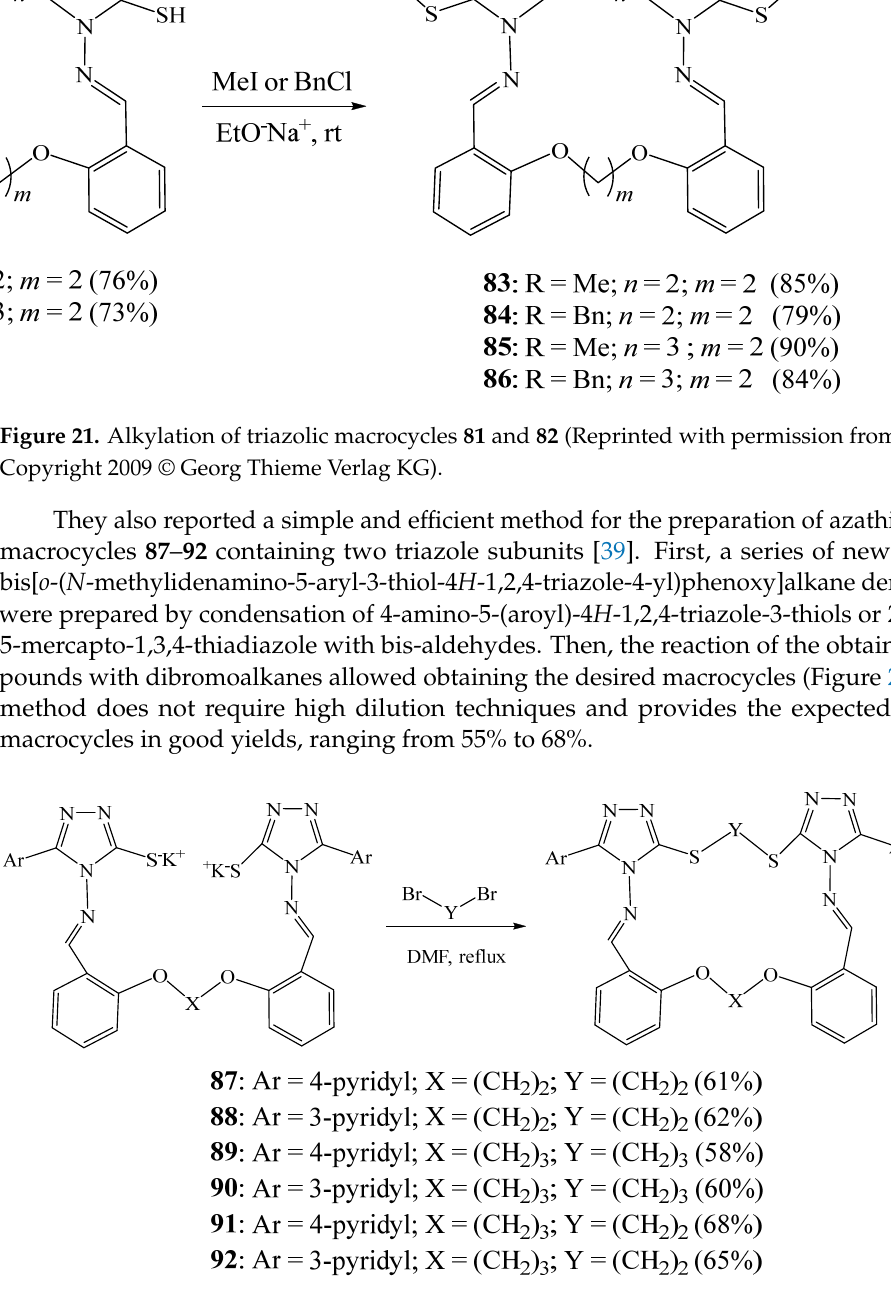
Figure 22. Cyclisation reaction to obtain macrocycles 87 − 92. (Reprinted with permission from ref. [39]. Copyright 2009 Elsevier).